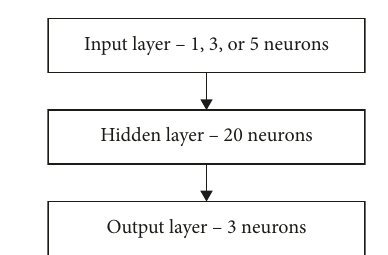
Figure 11: Structure of the proposed BNN.